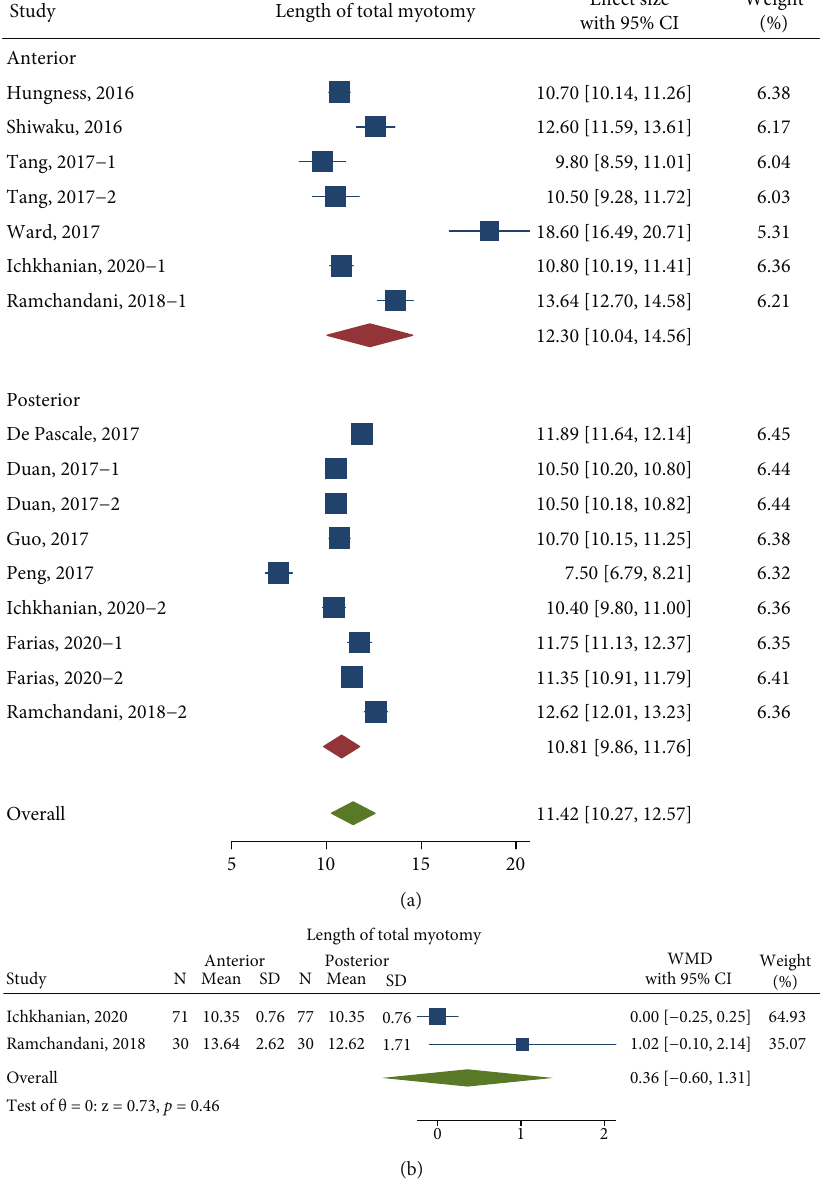
Figure 4: (a) Forest plot, Comparison of the length of total myotomy before balancing baseline; (b) Forest plot, Length of total myotomy di ff erence between anterior and posterior approaches after balancing baseline Labels 1 and 2 were sectionalizations inside the study. They grouped these factors as follows: preoperative intervention/non-preoperative intervention (Tang, 2017), FTM/CM (Duan, 2017), Chagas/ idiopathic (Farias, 2020), and anterior/posterior (Ramchandani, 2018; Tan,